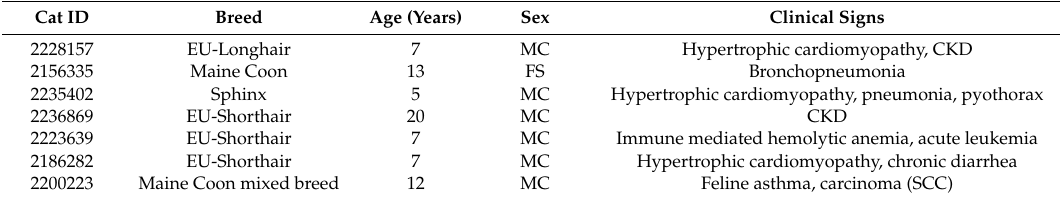
Table 7. Clinical information for selected FcaGHV1-positive